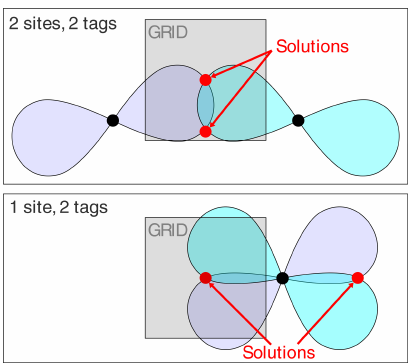
Figure 3. A 2-dimensional representation of isosurface intersection points for different tagging site geometries.